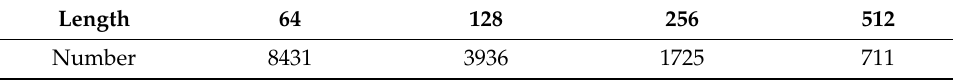
Table 1. The number of data obtained with different fixed lengths.